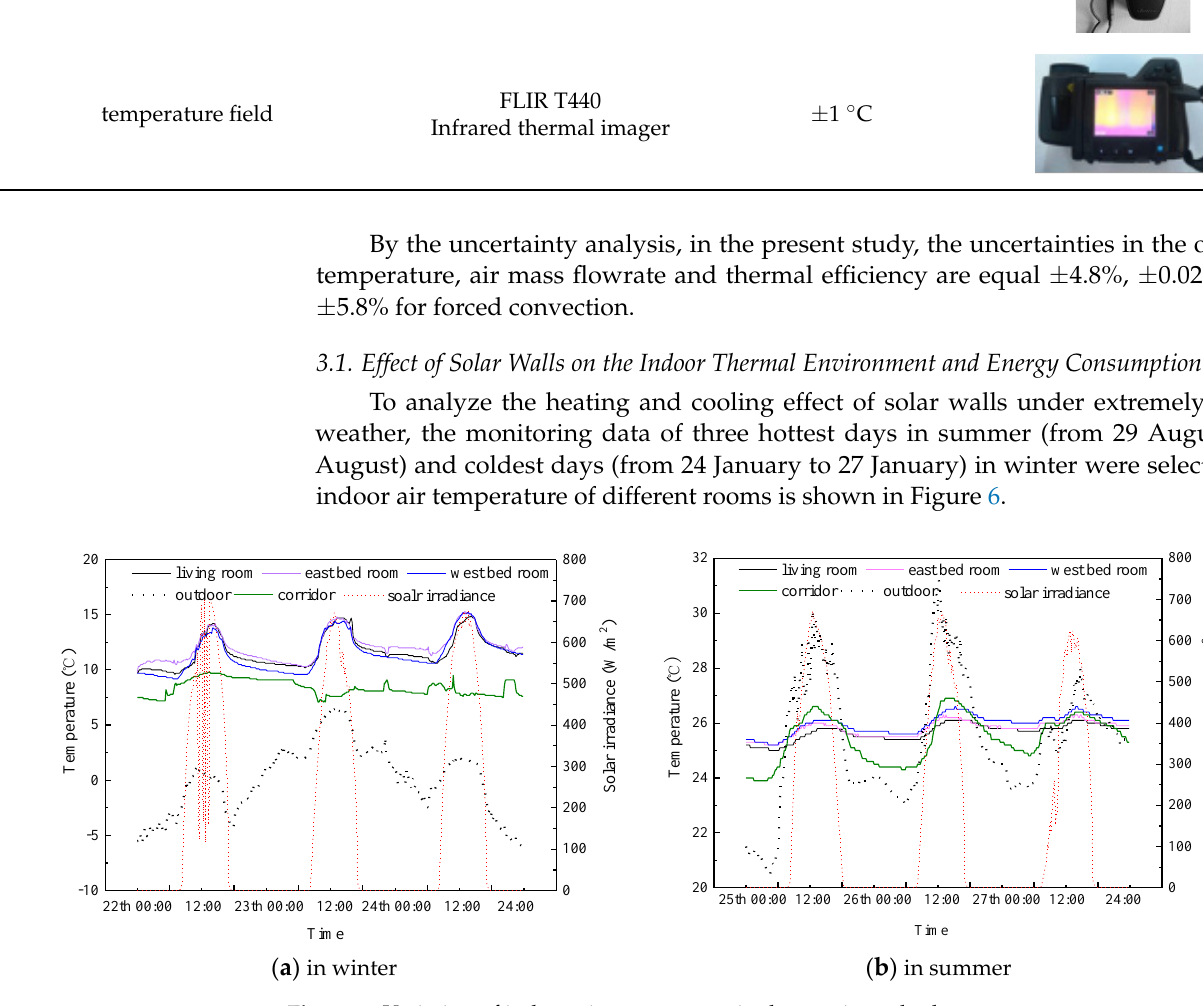
Figure 6. Variation of indoor air temperature in the passive solar house.